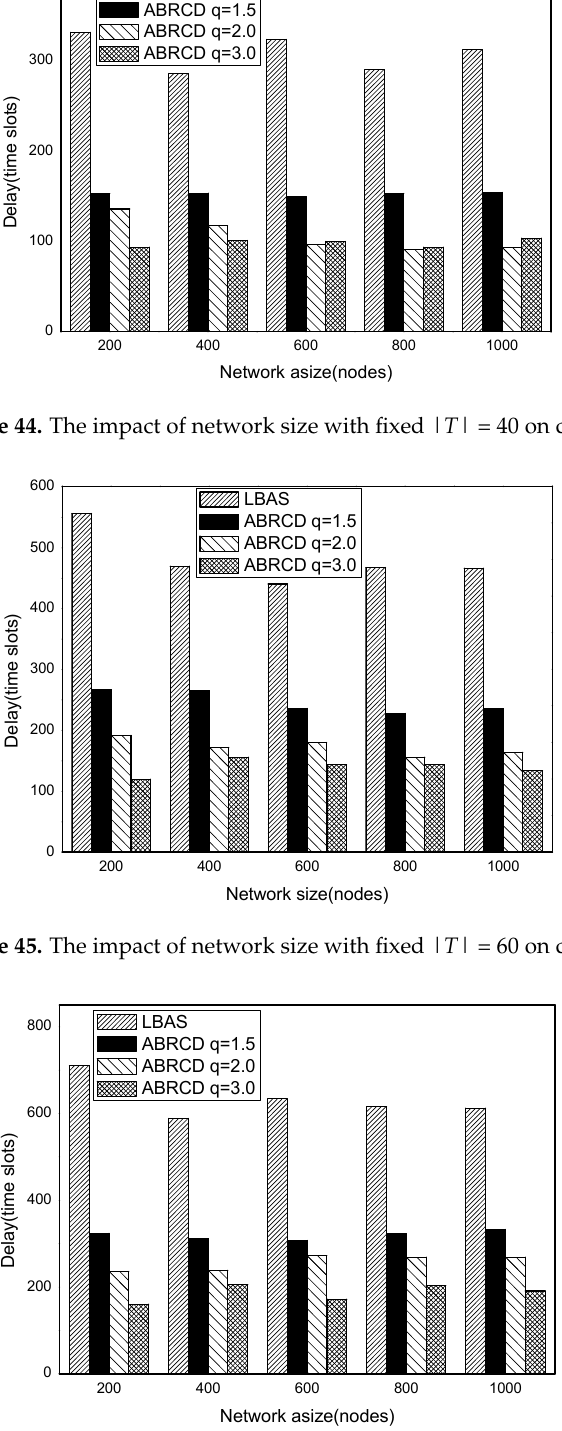
Figure 46. The impact of network size with fixed | T | = 80 on delay.